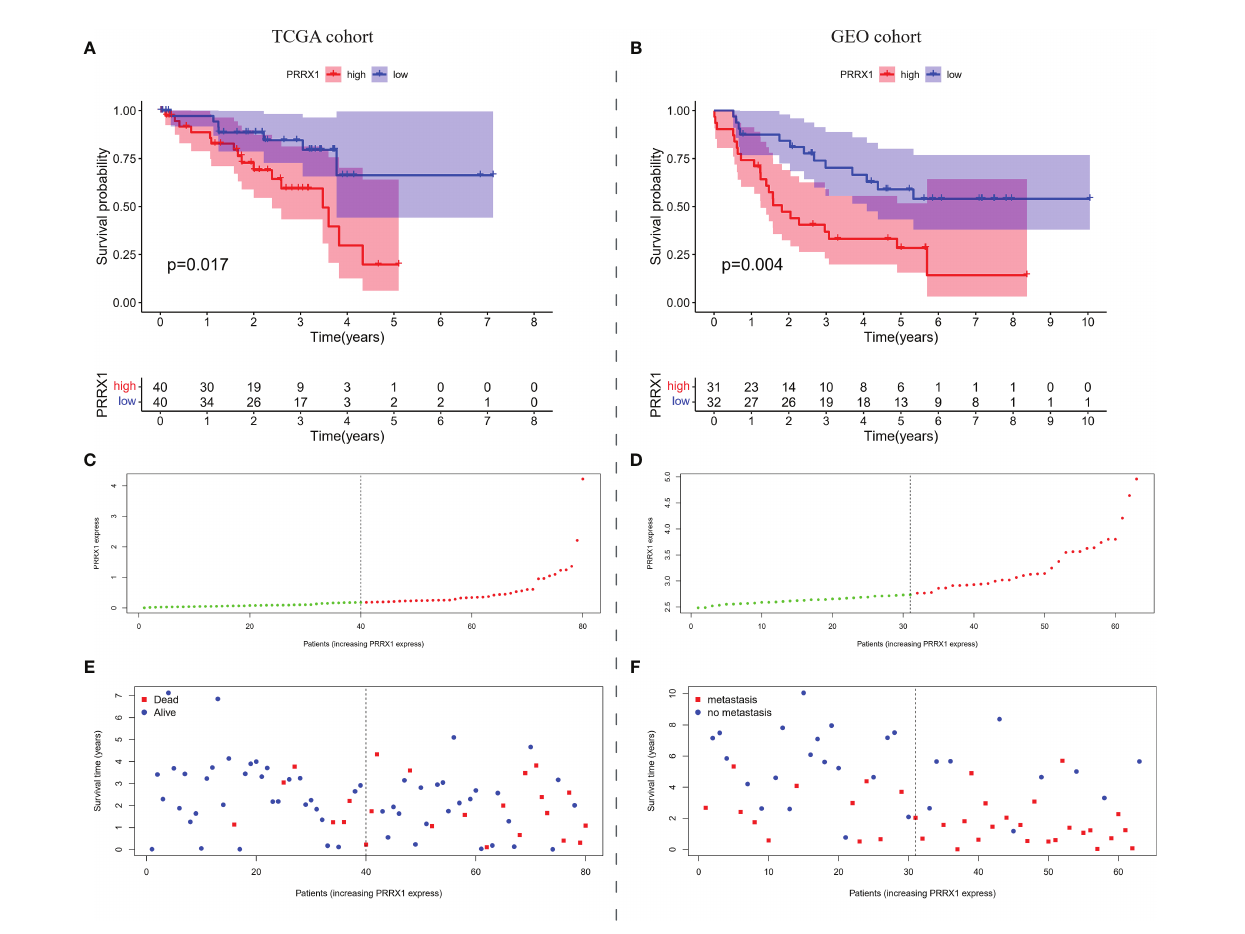
FIGURE 5 | The overall prognostic performance of PRRX1 expression in two UM cohorts. Kaplan – Meier analyses of (A) OS in TCGA cohort and (B) MFS in the GEO cohort, the numbers shown below the survival curves are the number of patients at risk at the speci fi ed year. Distribution of PRRX1 expression levels in the (C) TCGA and (D) GEO cohorts, the dotted line represented the median PRRX1 expression and divided the patients into low-expression (green dots) and high- expression groups (red dots). Percentages of (E) deceased patients (red dots) in the TCGA cohort and (F) patients with metastasis (red dots) in the GEO cohort as a function of PRRX1 expression